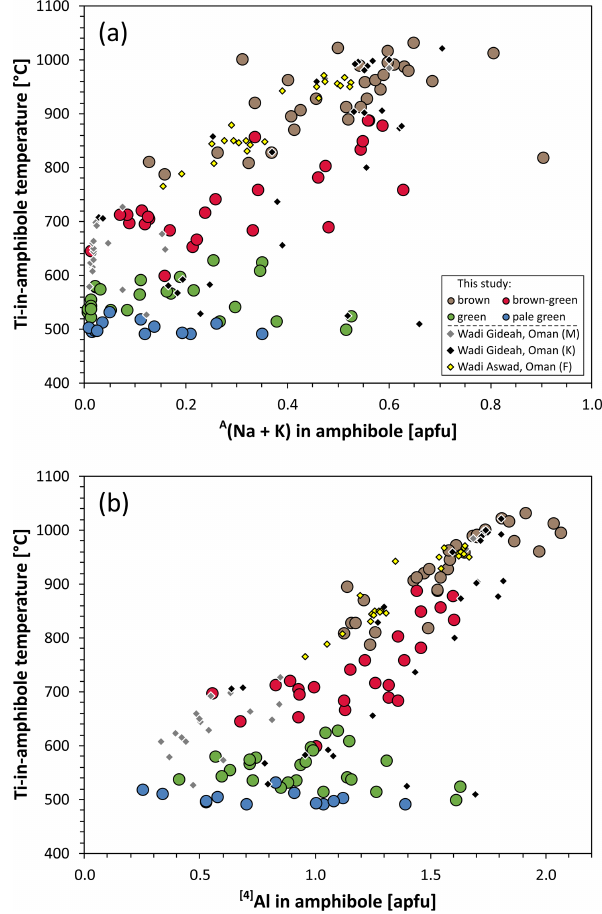
Figure 11. Relationship between tetrahedral Al and Na + K on the A position of the amphiboles versus the Ti-in-amphibole tempera- ture for the different groups, classified by mineral color. Also shown are amphibole data as comparison from other locations of the most southern blocks of the Oman ophiolite: Wadi Gideah (M: Müller et al., 2017, frozen AML; K: Koepke et al., 2022, layered gabbro) and Wadi Aswad (F: France et al., 2021). The amphiboles from the crustal level of a frozen AML show both low tetrahedral Al and A (Na + K) together with a lower Ti-in-amphibole temperature. In contrast, the layered gabbros from Wadi Gideah exhibit much more scattering, whereas the amphibole data from Wadi Aswad exhibit higher Ti-in-amphibole temperature for tetrahedral Al and A (Na + K), showing an overlap with the brown and brown-green amphiboles from this